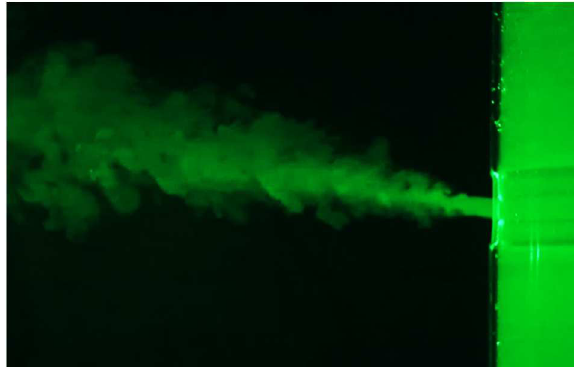
Fig. 5. An example of a LIF instantaneous image.